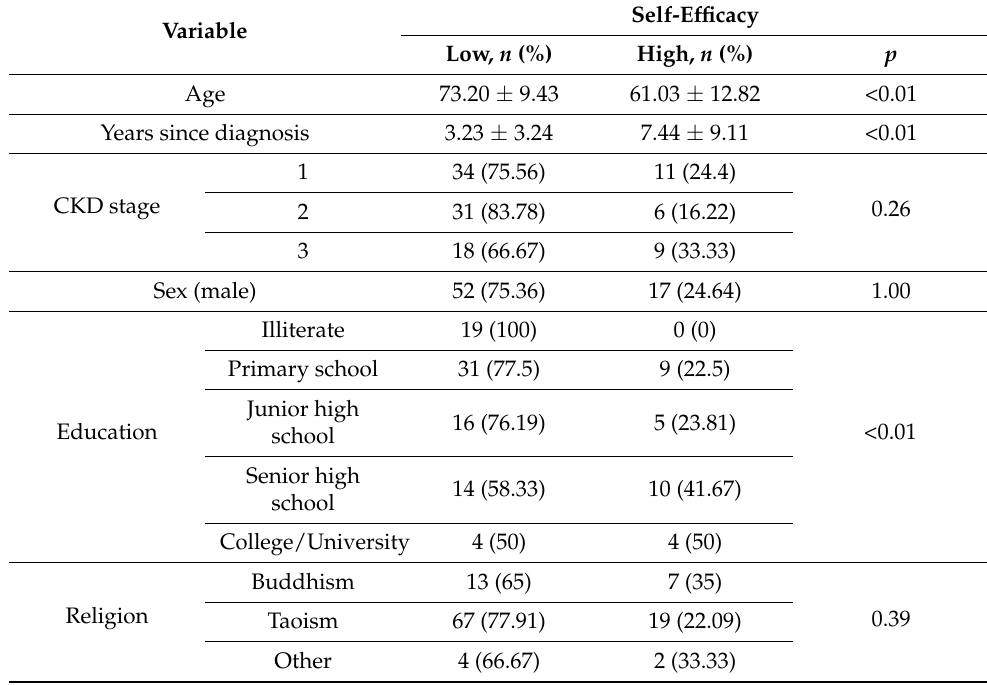
Table 4. Distribution of variables according to the self-efficacy level of the study